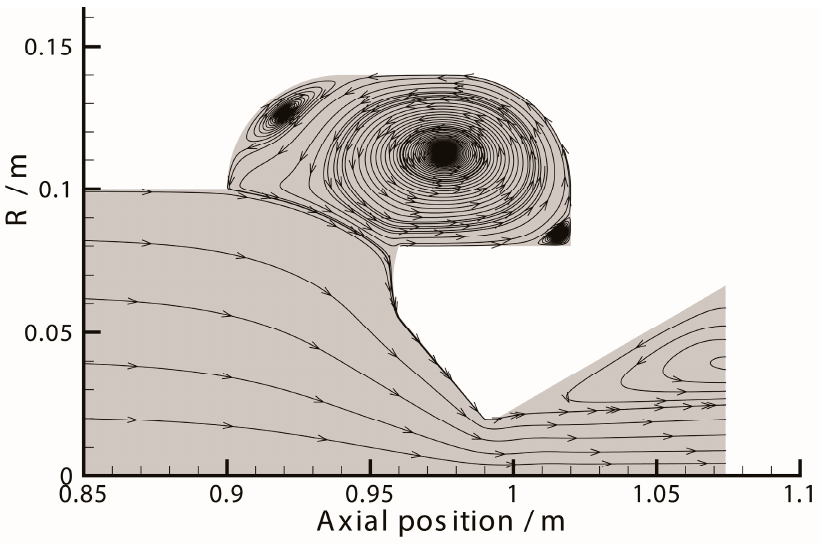
Figure 8. Streamlines of submerged nozzle at case C0.